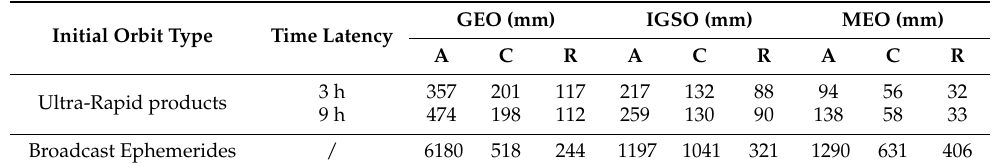
Table 3. Orbit accuracy of Ultra-Rapid products and Broadcast